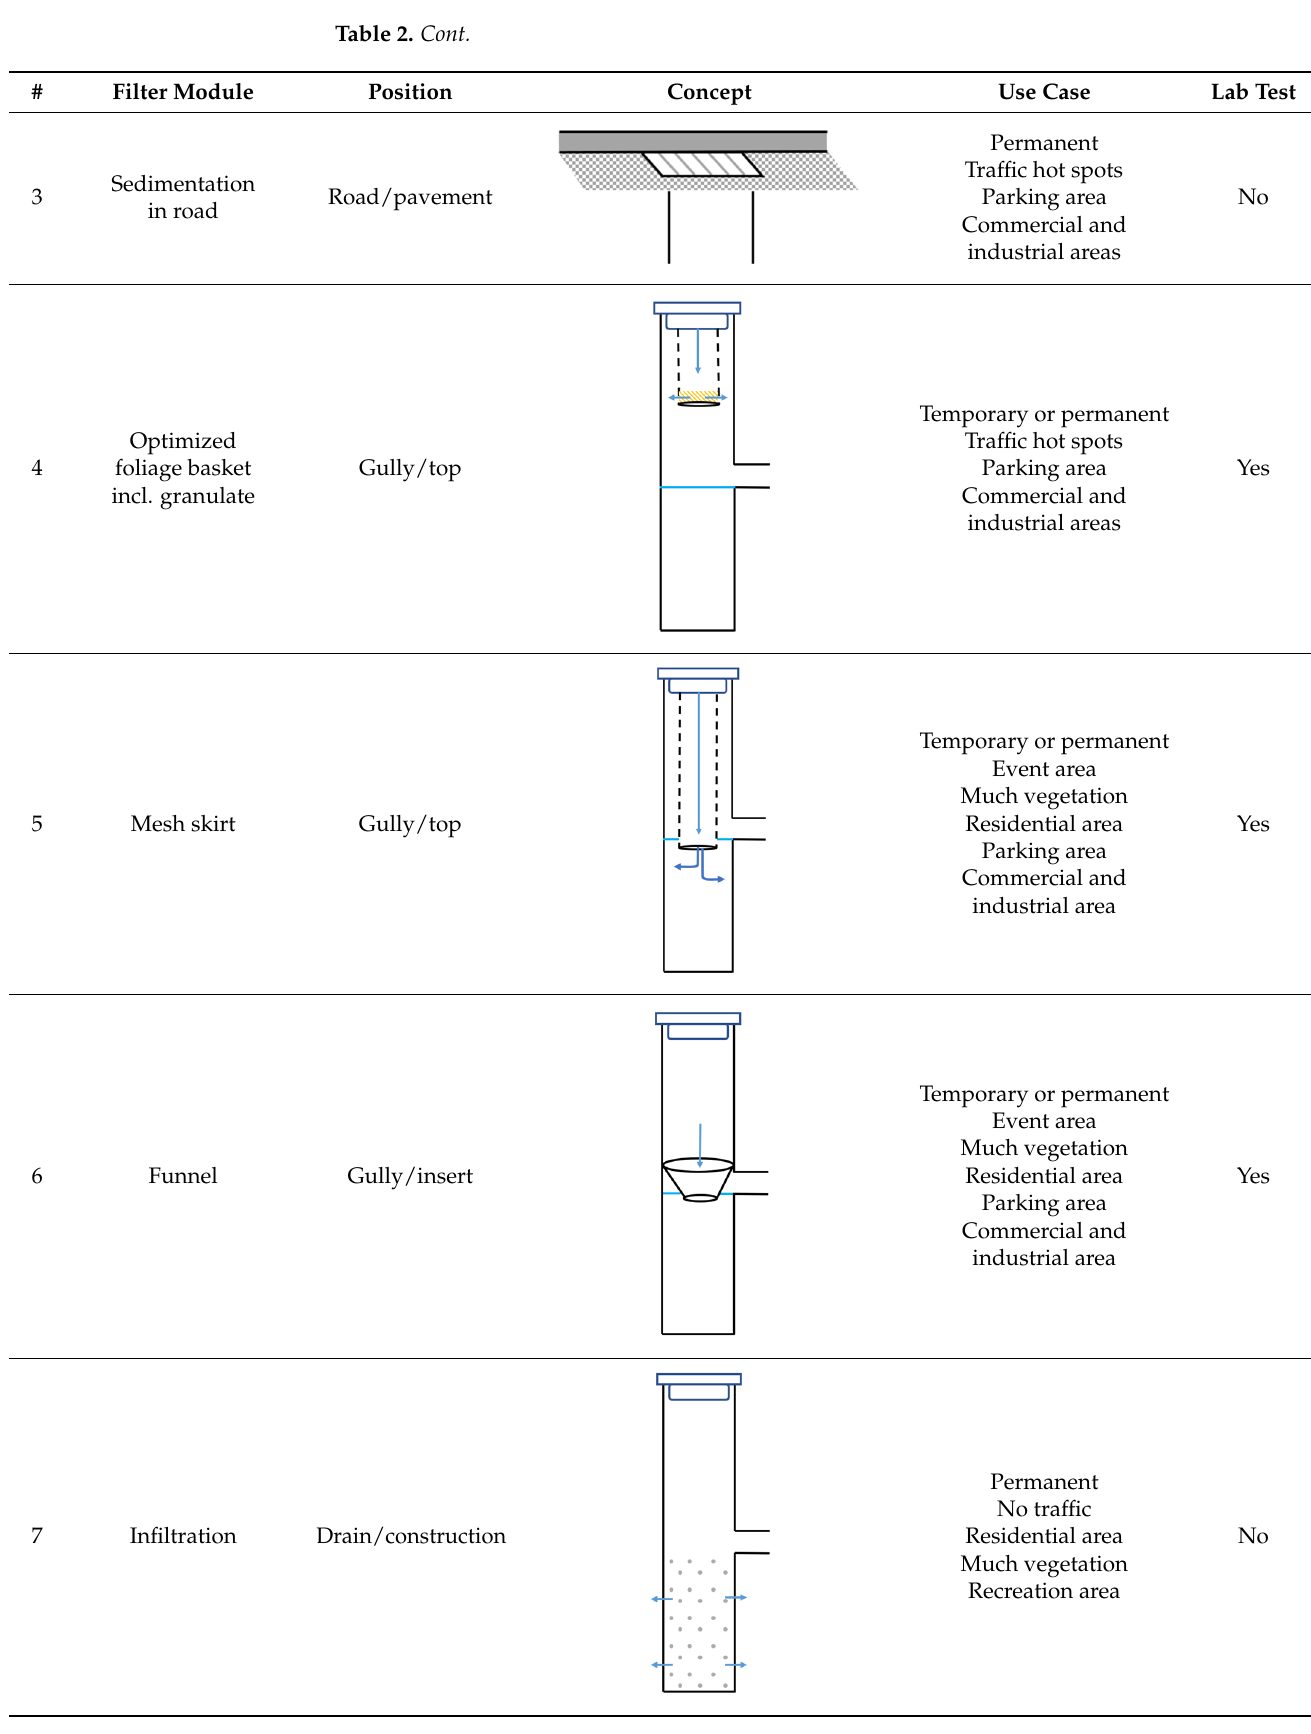
Table 2. Overview and evaluation of the tested filter modules.